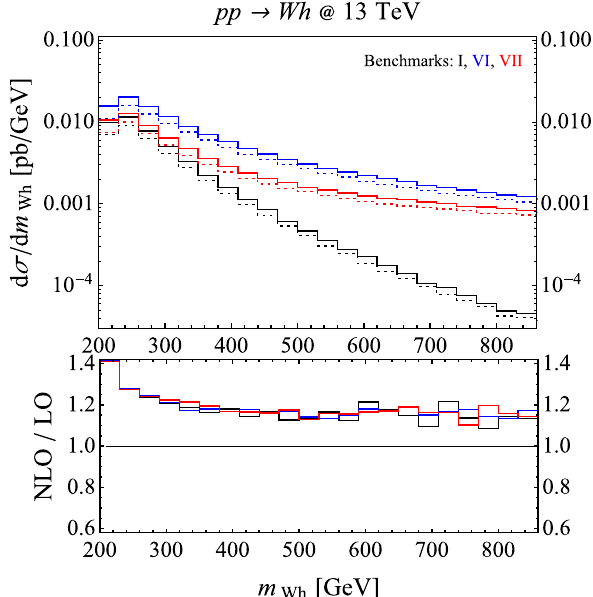
Fig. 2 Invariant mass distribution of the W H system in pp → W